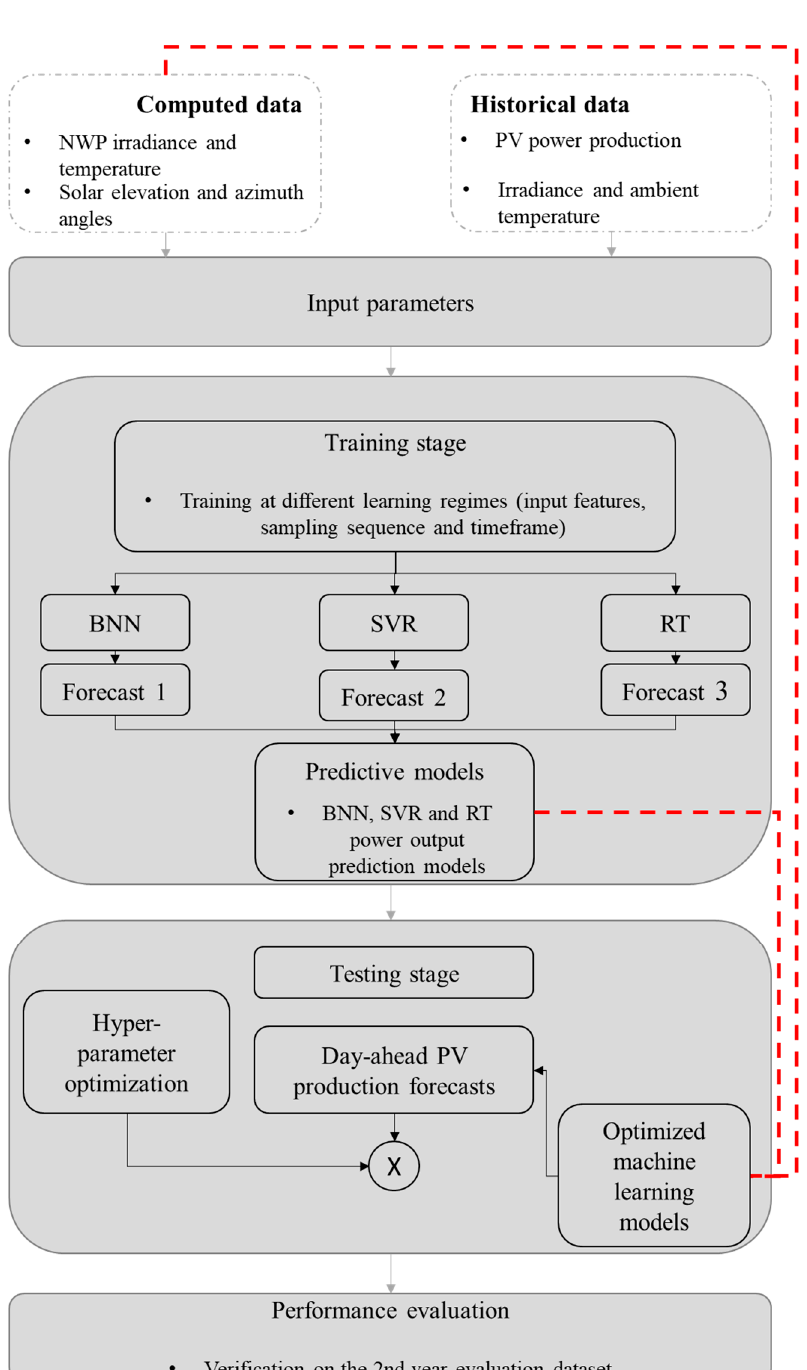
Figure 1. Flowchart of the proposed day-ahead photovoltaic (PV) production forecasting method- ology.